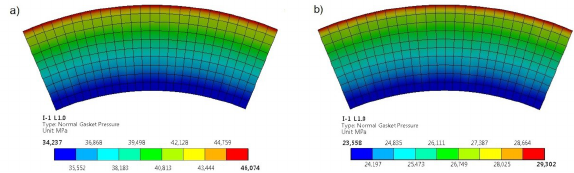
Figure 11: Contact stress distribution in operating state and flange load corresponding to tightness L1.0 a) joint gasketed with FG_1 b) joint gasketed FG_2